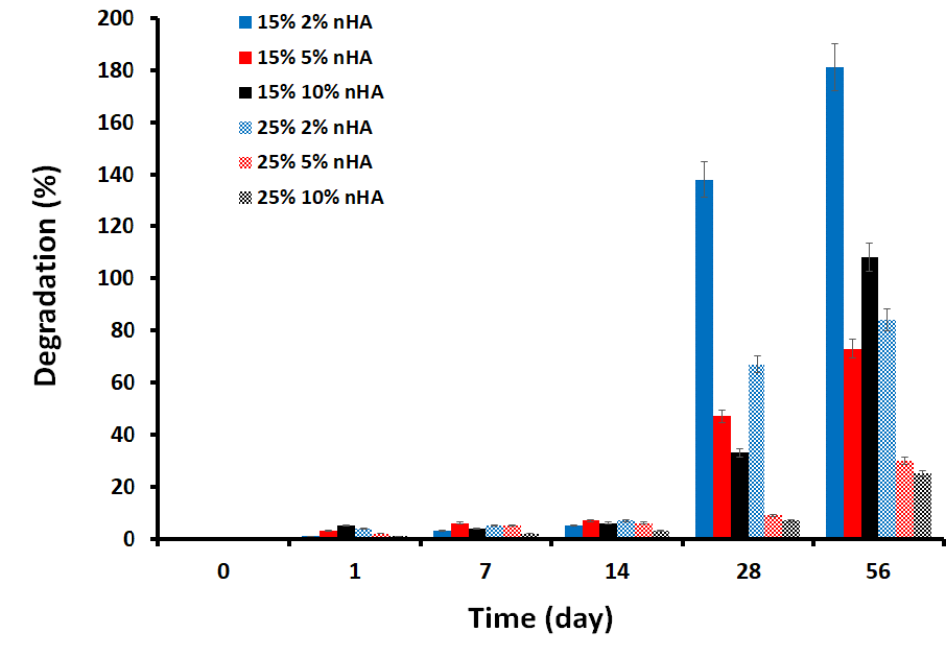
Figure 9. In vitro degradation of the GA/chitosan/nHA nanocomposite hydrogels in phosphate buffered saline (PBS) at 37 °C.